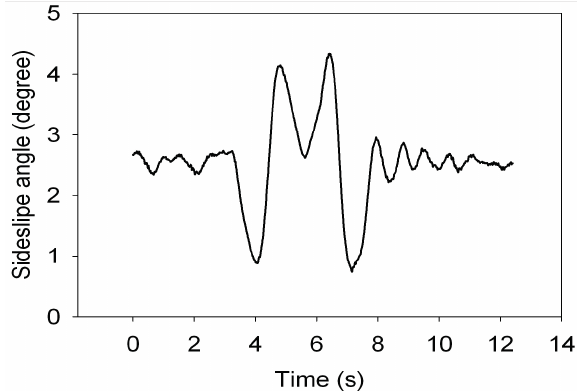
Figure 10. Measurement of the hybrid electric vehicle with RT3012.